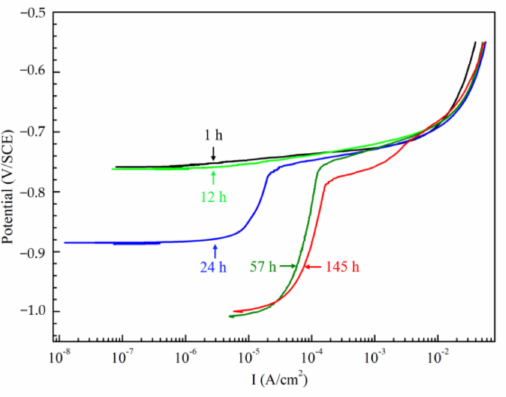
Figure 5. Anodic plots of Al–BN ACS with different immersion times in 5.0 wt % NaCl solution.